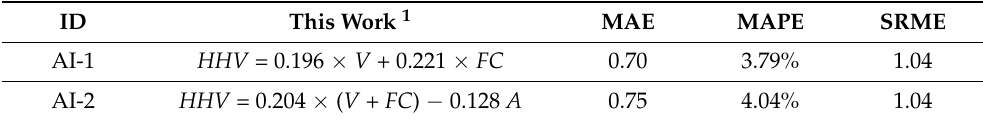
Table 9. Proposed equations, AI-1 and AI-2, based on proximate analysis.